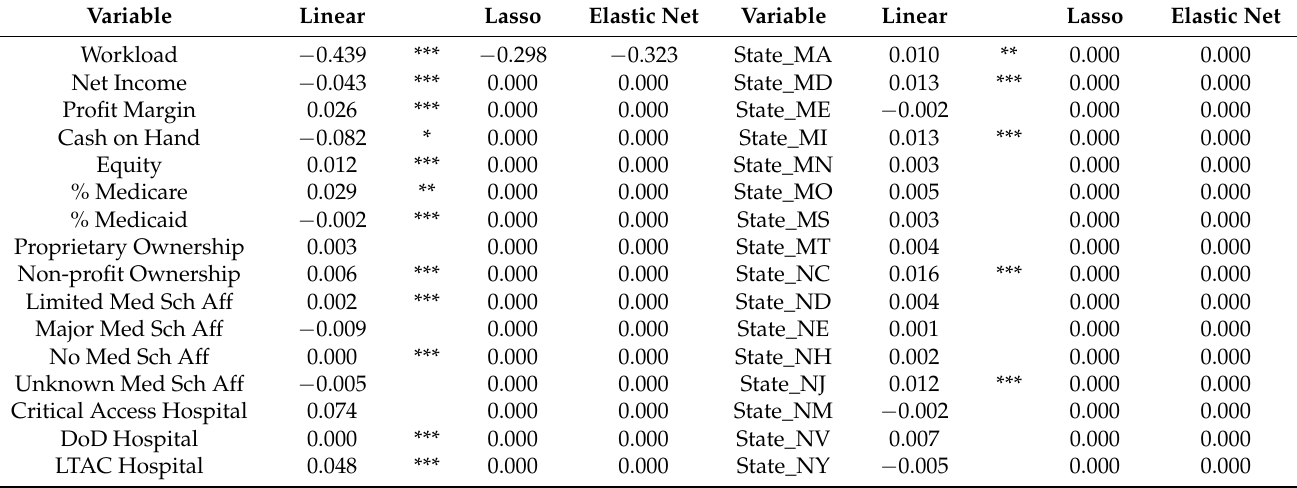
Table A1. Results of regression analyses for the number of diagnoses, hospital unit of